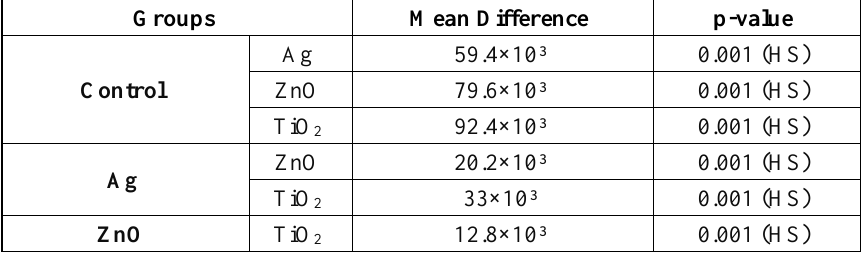
Table 3: Post hoc Tukey’s test of the CFU/mL in different